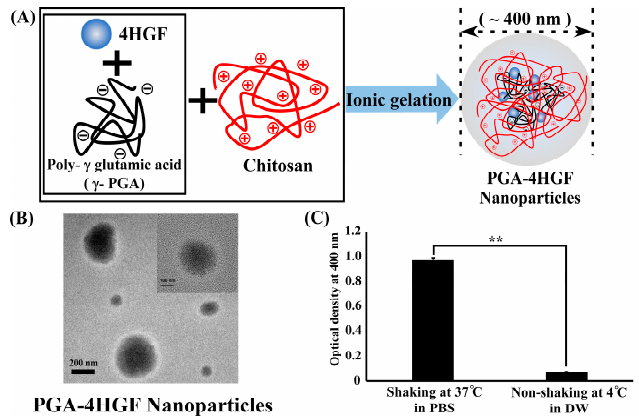
Figure 1. ( A ) Scheme of the complex formation between the polyanions (poly- γ -glutamic acid ( γ -PGA)) and the polycation (chitosan) and the capsulation for 4HGF into PGA/chitosan nanoparticles. ( B ) TEM images of PGA-4HGF nanoparticles (left, PGA-4HGF, scale bar = 200 nm; right, PGA-control, scale bar = 100 nm). ( C ) Comparison of optical density from the release of 4HGF entrapped within PGA-4HGF after 6 h incubation at di ff erent conditions. Data was analyzed with paired t -test (** p <